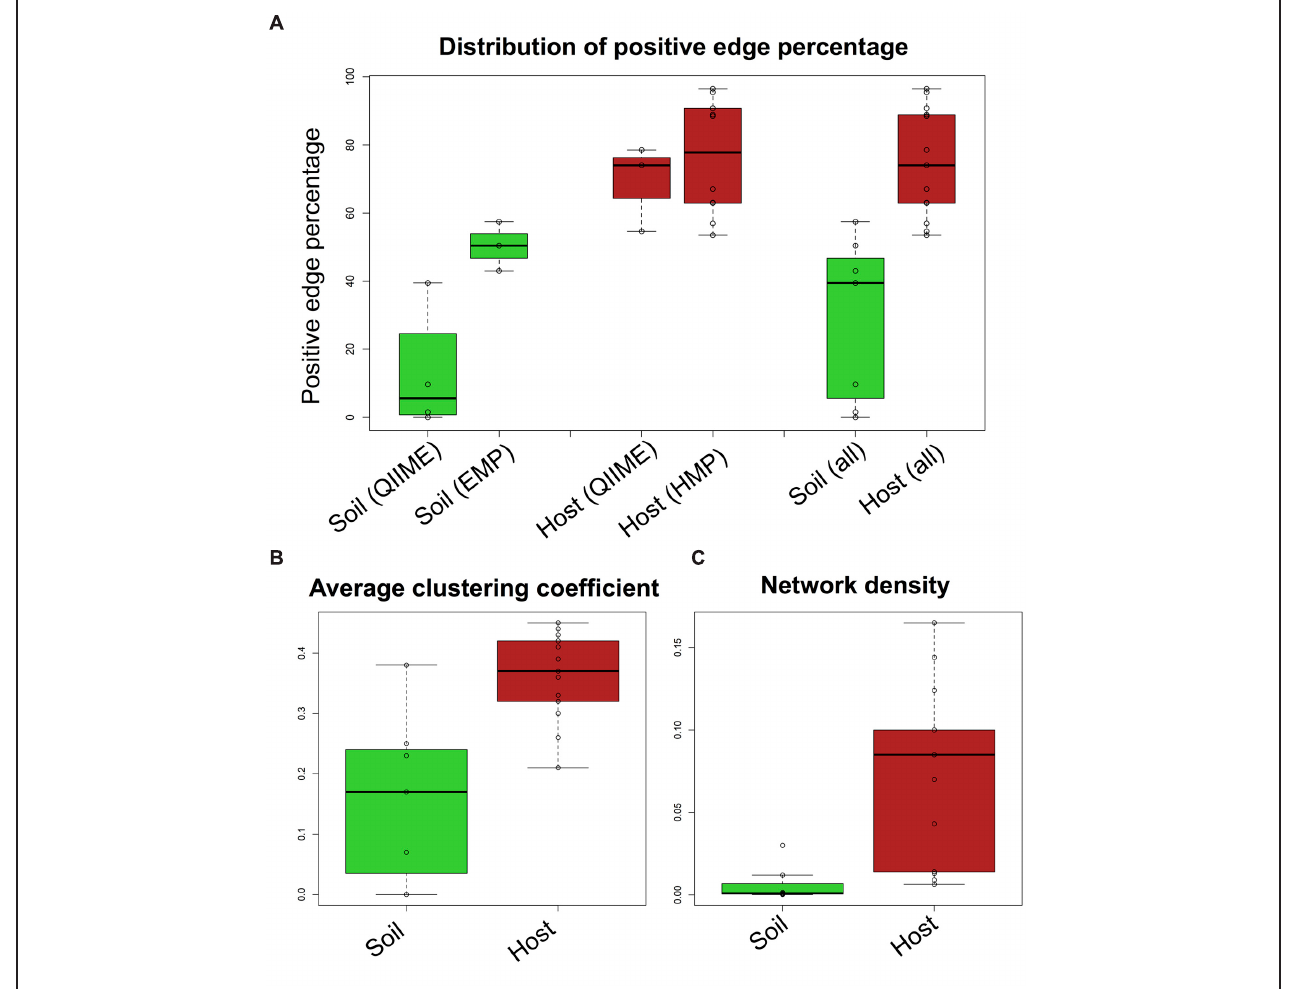
FIGURE 2 | Differences between host and soil networks. Soil networks fall into two groups, characterized by low (QIIME soils) and high sequencing depth [Earth Microbiome Project (EMP) soils], whereas host networks constructed from QIIME and Human Microbiome Project (HMP) samples have comparable PEP. When taking all networks together, PEP in soil is significantly lower ( p -value: 0.0002 according to the Wilcoxon rank sum test) than in host (A) . The average clustering coefficient (B) and network density (C) are also significantly different ( p -values: 0.004 and 0.002, Wilcoxon rank sum test). Network density is computed as 2E/N(N-1), where E is the edge number and N the number of taxa in the processed